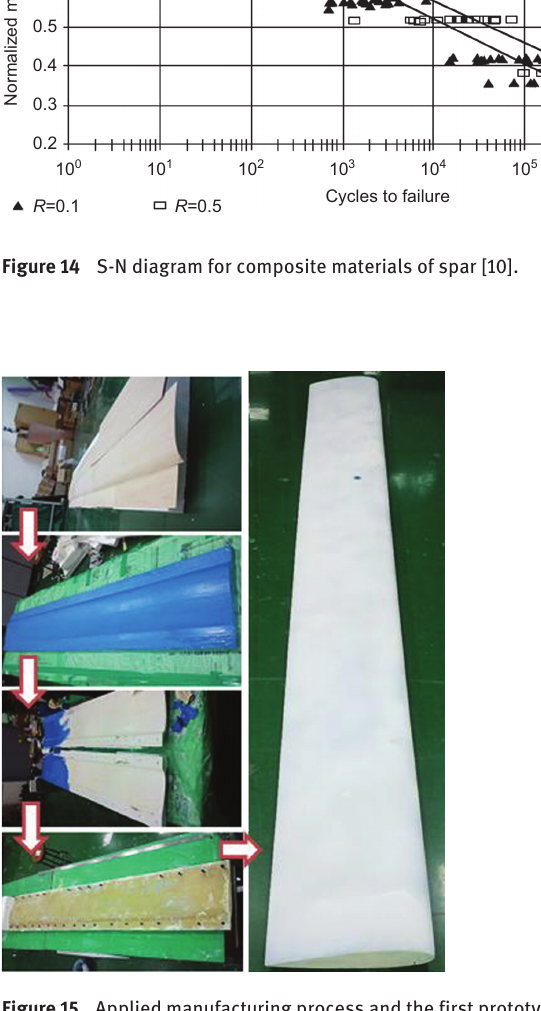
Figure 15 Applied manufacturing process and the first prototype blade.